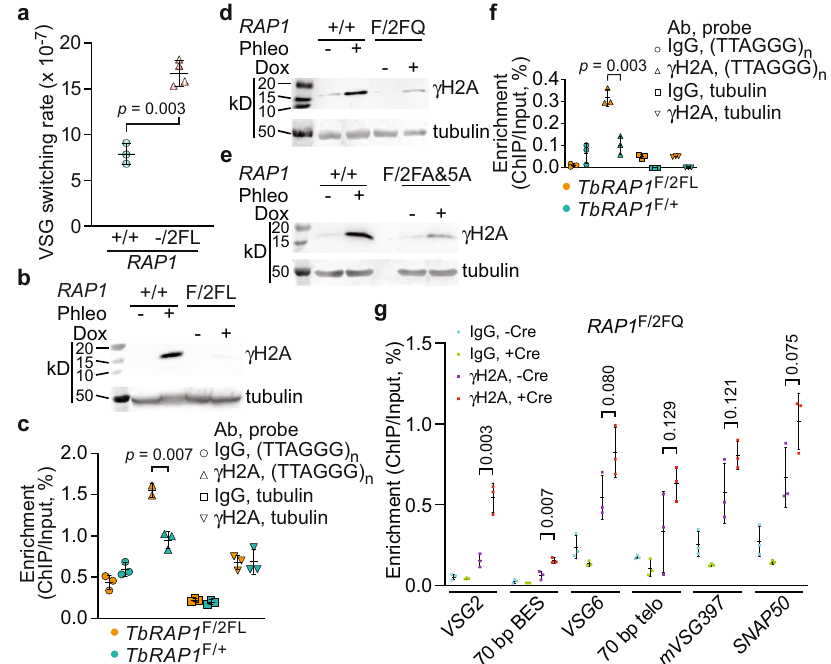
Fig.6 | Tb RAP1RRMmutantshaveanincreasedamountofDNAdamageatthe telomere and the subtelomere. a TbRAP1 -/2FL exhibits an increased VSG switching rate. Average and standard deviation were calculated from three (WT) and four ( TbRAP1 -/2FL ) independent experiments. P values of two-sided unpaired t -tests are shown ( TbRAP1 -/2FL vs TbRAP1 +/+ ). b , d , e Western analyses to examine the γ H2A protein level in WT cells before and after phleomycin treatment (as a positive control)andin TbRAP1 F/2FL ( b ), TbRAP1 F/2FQ ( d ),and TbRAP1 F/2FA&5A ( e )cellsbeforeand after a 30 – 48h Cre induction. A γ H2A rabbit antibody 23 and the tubulin antibody TAT-1 49 were used. Molecular marker was run on the left lane in each gel and their sizes are indicated on the left. c , f ChIP using the γ H2A rabbit antibody and IgG in TbRAP1 F/2FL ( c ) and TbRAP1 F/2FQ ( f ) cells after a 30h Cre induction followed by Southern blotting using a telomere and a tubulin probe. Blots were exposed to a